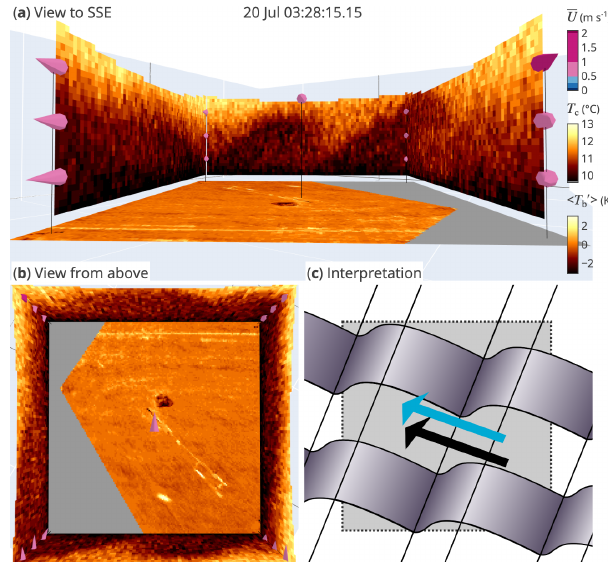
Figure 10. Nighttime example of structures and motion in air and surface temperature represented by fibre-optic cable temperature ( T c ) and surface brightness temperature ( T b ) variance, respectively. Shown are (a) a viewpoint from NNW, (b) a perspective from above and (c) a conceptual interpretation. Observations of wind are shown as cones pointing in the direction of the mean wind ( U ).